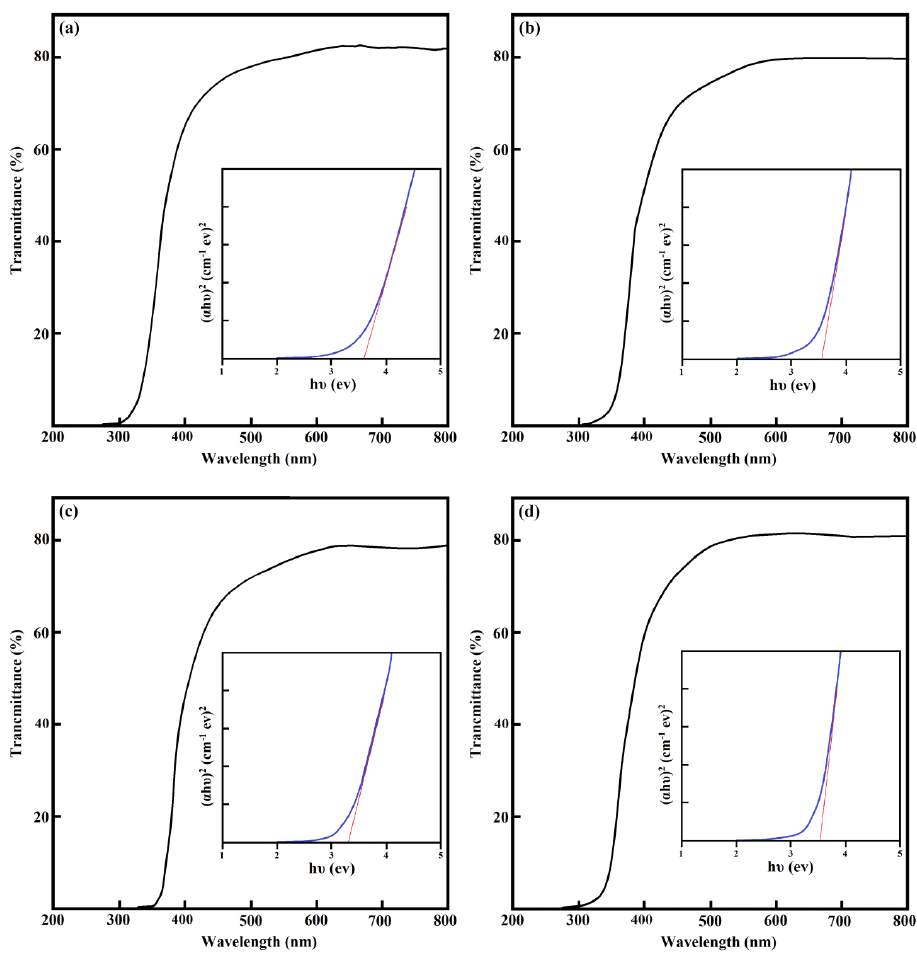
Fig. 5. Transmittance spectra and band gap of (a) BSO, (b) BSS1, (c) BSS2 and (d) BSS3 thin